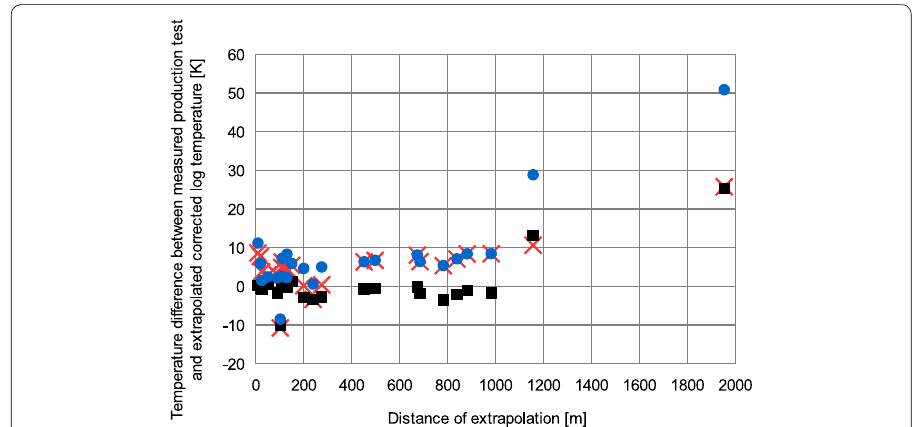
Fig. 13 Temperature difference between production test temperatures and extrapolated log temperatures for the three correction methods. Blue dots: method A; black squares: method B; red crosses: method